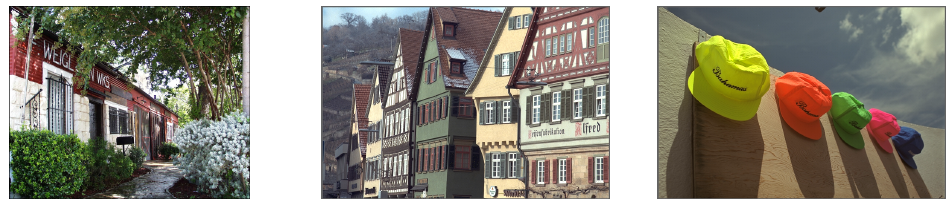
Figure 4. Sample images from LIVE1 [54] dataset. (Left to right) 1.bmp , 2.bmp , 3.bmp , and 4.bmp